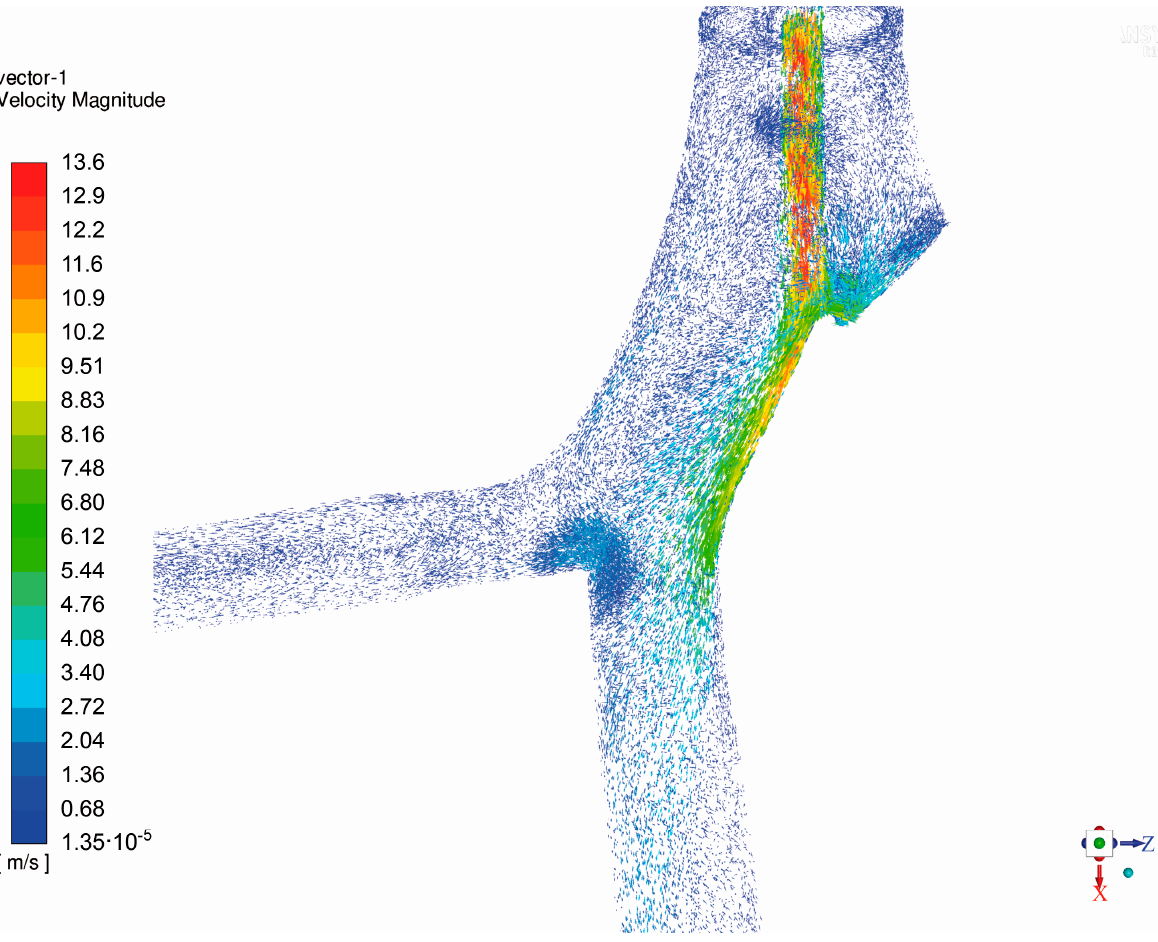
Figure 4. The air velocity profile obtained in the analyzed computational domain during inhalation phase (steady air flow assumed).